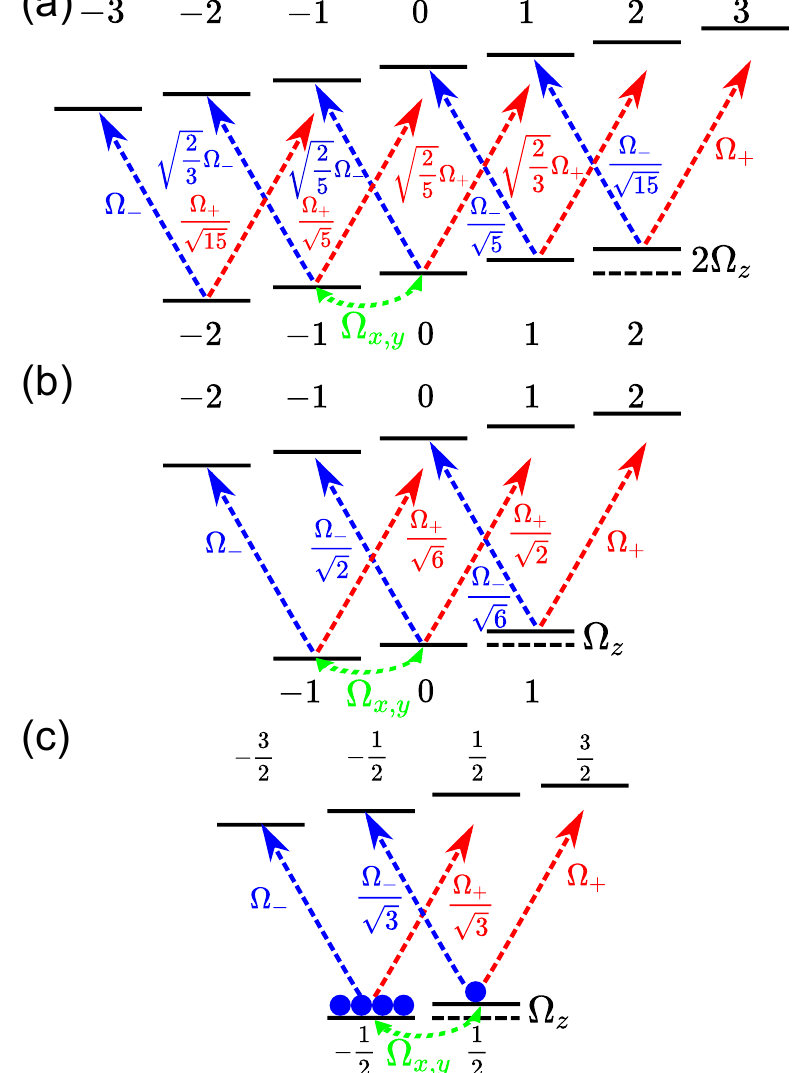
Figure 7. ( a ) Level structure of F = 2 → F (cid:48) = 3 hyperfine transition line of D 2 -line of 87 Rb. Red (blue) arrows indicate transitions via σ + ( σ − ) light with Rabi frequencies Ω + ( Ω − ) with strength relative to the strongest transitions between the stretched states. A longitudinal magnetic field with Larmor frequency Ω z splits the Zeeman sublevels. For simplicity, the g − factor for the ground state is assumed to apply also for the excited state. Transverse magnetic fields Ω x , Ω y will induce coherences between Zeeman sublevels (for simplicity only one is shown). ( b ) Reduced scheme of a F = 1 → F (cid:48) = 2 transition used in the theoretical description. It includes the possibility of orientation (irreducible tensor rank 1) and alignment (rank 2) states in the ground state. ( c ) Further reduced scheme of a F = 1/2 → F (cid:48) = 3/2 transition keeping only the possibility of an orientation. In this situation, it is illustrated that an orientation with an increased population in the state with m < 0 leads to a back-action on the light increasing absorption and phase shift for the σ − -component. This orientation can be created by a dominance of σ − - over σ + -light, or for linearly polarized light by the incoherent Faraday